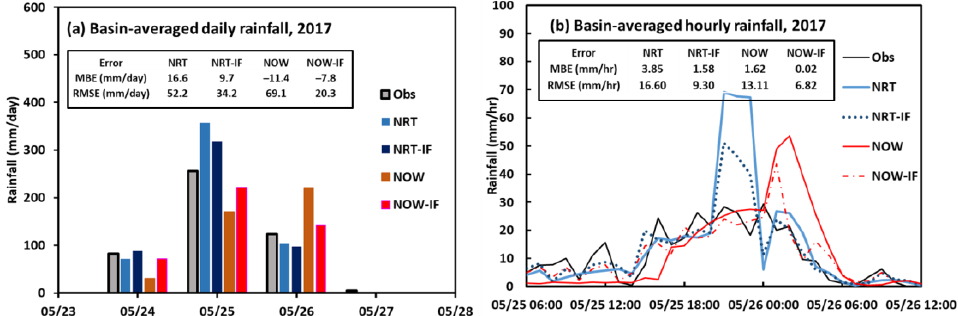
Figure 6. Comparison of basin-averaged GSMaP raw and bias-corrected (IF) rainfall products for May 2017 event: ( a ) daily rainfall (mm/day) and ( b ) hourly rainfall (mm/h).